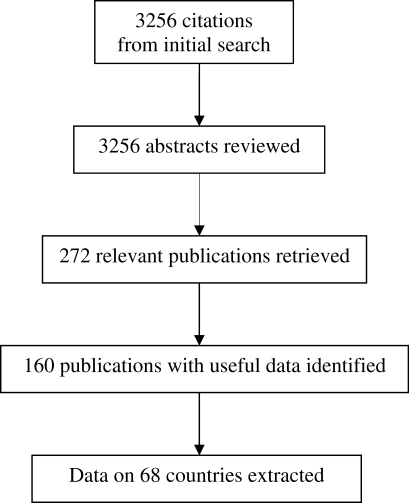
Schematic Diagram of the Steps of the Literature Review